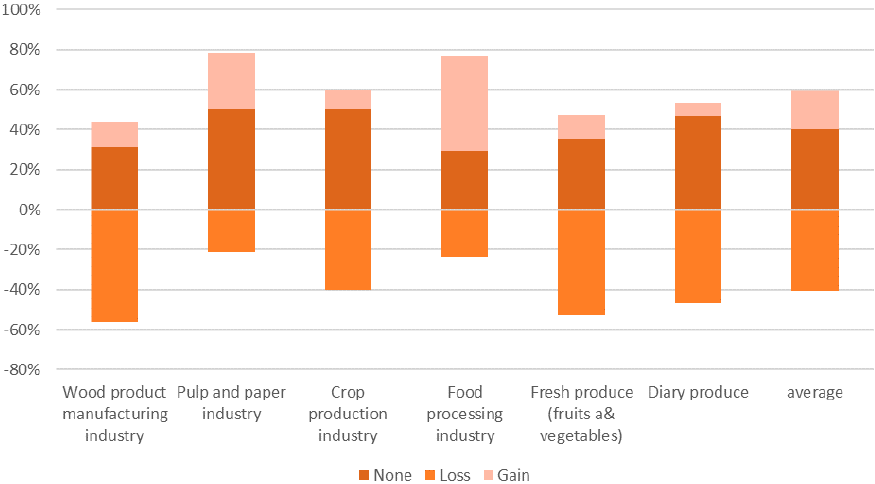
Figure A3. Aggregated results for economic disturbances in biomass supply chains from the demand side reported by experts.